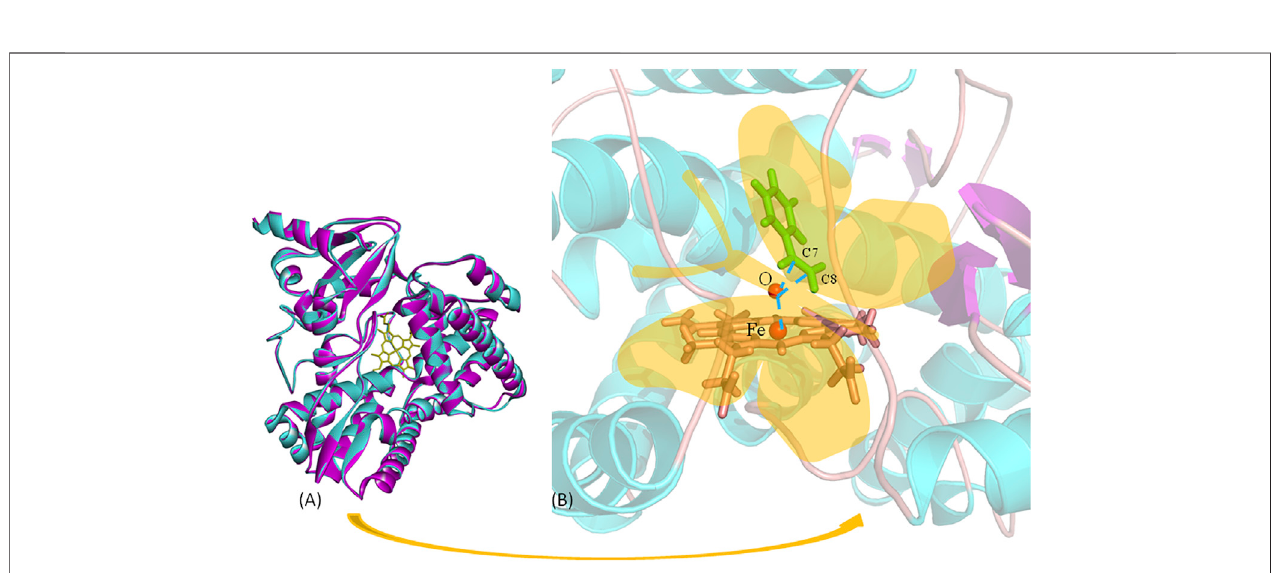
FIGURE 2 | Butter fl y model-based structure and computational analysis. (A) Overlay structure for aMOx (cyan) and the model (purple) CYP116B5 (PDB No.: 6RO8). (B) “ Butter fl y ” catalytic model for P450 aMOx.